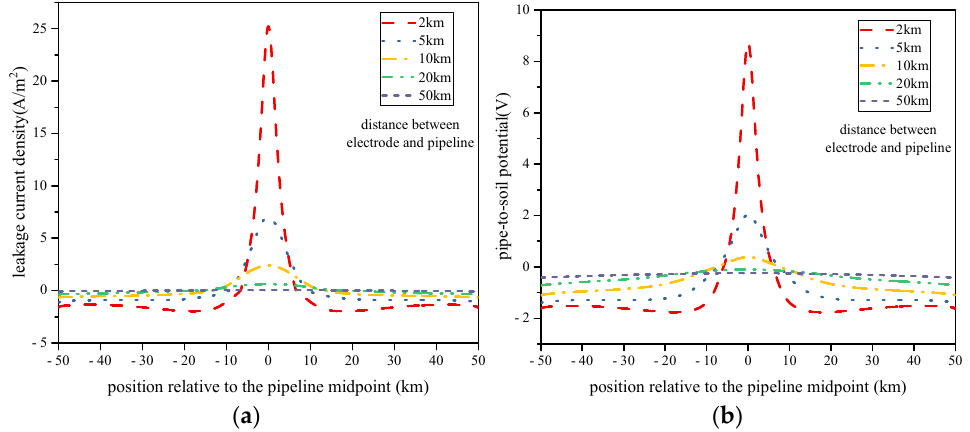
Figure 12. Calculation results under different distance between electrode and pipeline. ( a ) leakage current density along the pipeline; ( b ) PSP along the pipeline.